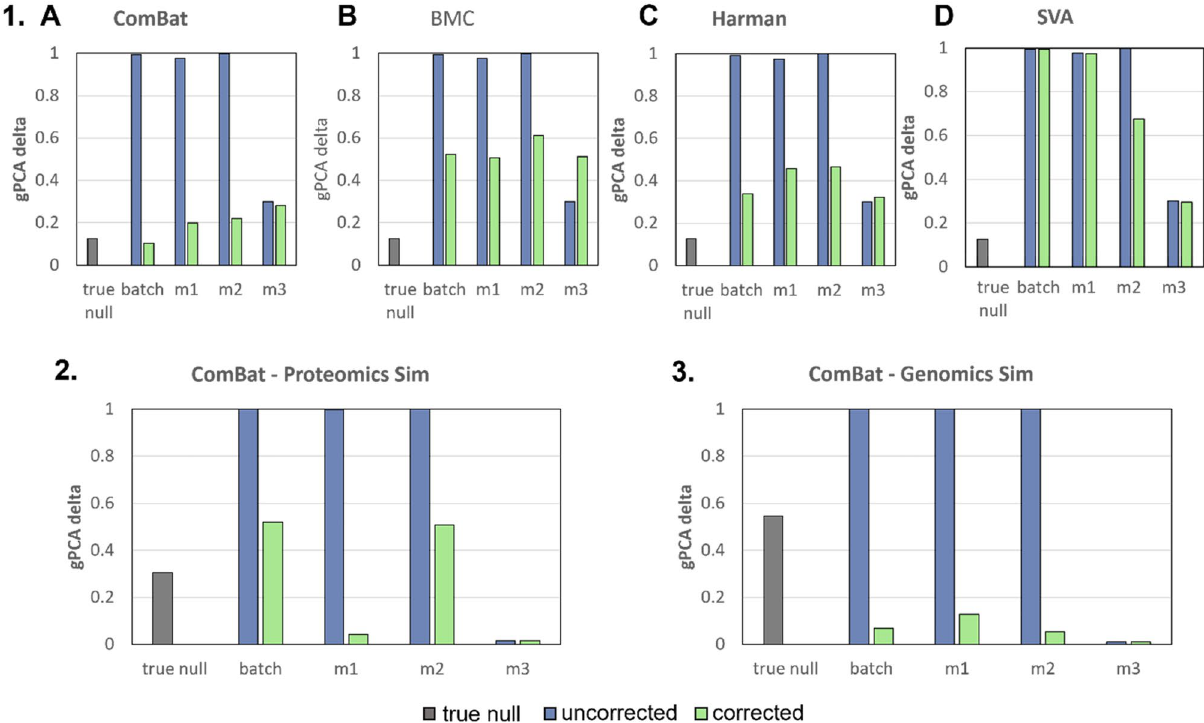
Figure 3. 4 Batch effect correction algorithms (BECAs) are used for evaluation of batch correction for 1. Initial Simulation based on the gPCA delta: ( A ) ComBat ( B ) BMC ( C ) Harman ( D ) SVA. Only ComBat is used for evaluation of batch correction for 2. Proteomics Simulation and 3. Genomics Simulation based on the gPCA delta. Lower values indicate less batch-correlated separation in